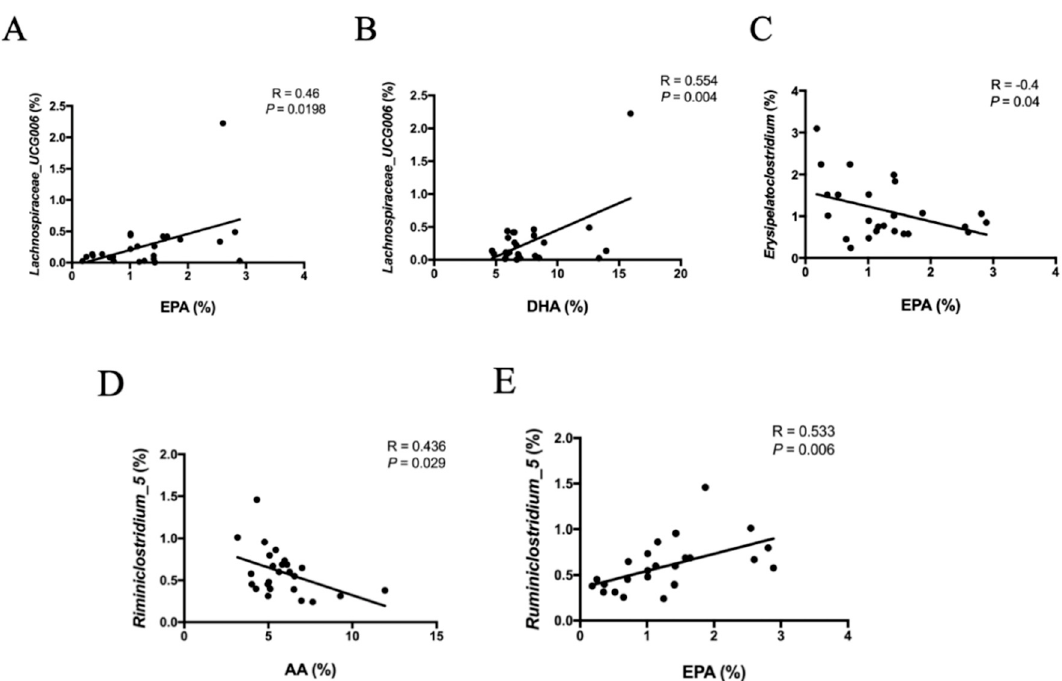
Figure 6. ( A ) and ( B ) Pearson correlation between relative abundance of Lachnoapiraceae_UCG006 and percentage of EPA and DHA in the hippocampus, respectively. ( C ) Pearson correlation between relative abundance of Erysipelatoclostridium and percentage of EPA in the hippocampus. ( D ) and ( E ) Pearson correlation between relative abundance of Ruminiclostridium_5 and percentage of EPA and arachidonic acid (AA) in the hippocampus, respectively. A value of p < 0.05 indicates a significant correlation.